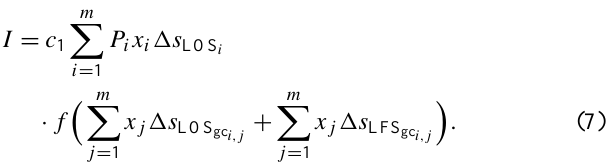
Figure 4. Two-dimensional intersection of Earth’s atmosphere, with the center of Earth, M, and the altitudes as radii of the circles. Path lengths along the line of sight for the vertical grid can be found with right-angled triangle algebra. Changes of the latitude are marked with red crosses as additional “a” sides. The path length in each grid cell is the difference of the a sides of neighboring grid cells. Note that, depending on the binning of the latitudes, it is possible that all grid cells only have one latitude (taken from Langowski et al.